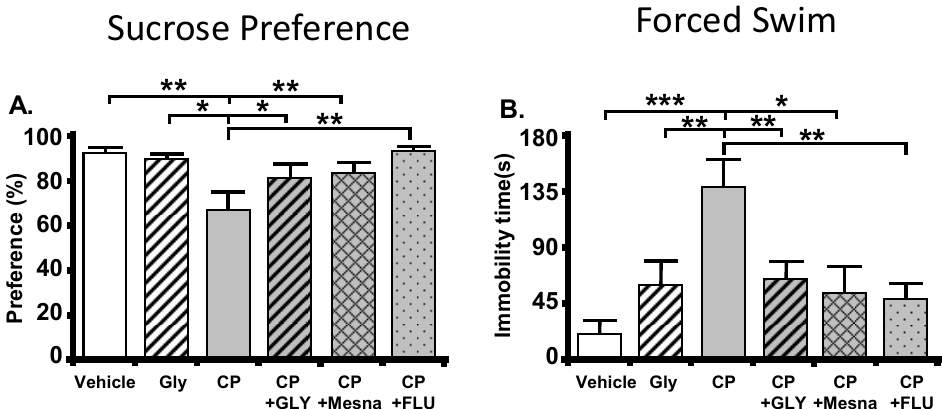
Figure 3. CP induces behavioral signs of depression through NLRP3. ( A ). Sucrose preference test. A reduction of preference indicates depression. Bars represent the mean ± SEM. [Vehicle: n = 10; GLY: n = 4; CP: n = 8; CP + GLY = 6; CP + Mesna = 12; GP + FLU=8]. * p < 0.05 and ** p < 0.01 by one-way ANOVA and Student-Newman-Keuls post-hoc analysis. ( B ). Forced Swim assay. An increase in time spent immobile indicates depression. Bars represent the mean ± SEM. [Vehicle: n = 9; GLY: n = 18; CP: n = 8; CP + GLY = 18; CP + Mesna = 6; GP + FLU = 11]. * p < 0.05, ** p < 0.01 and *** p < 0.001 by one-way ANOVA and Student-Newman-Keuls post-hoc analysis. This figured was reprinted, with permission from the American Physiological Society, from